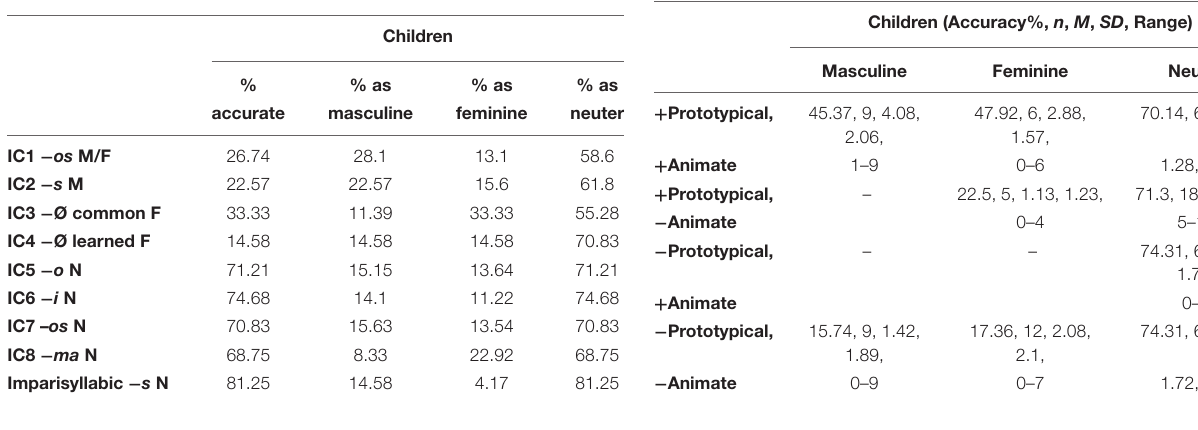
TABLE 7 | Accuracy, number of items, mean number, standard deviation, and range of correct responses per prototypicality condition in the younger group